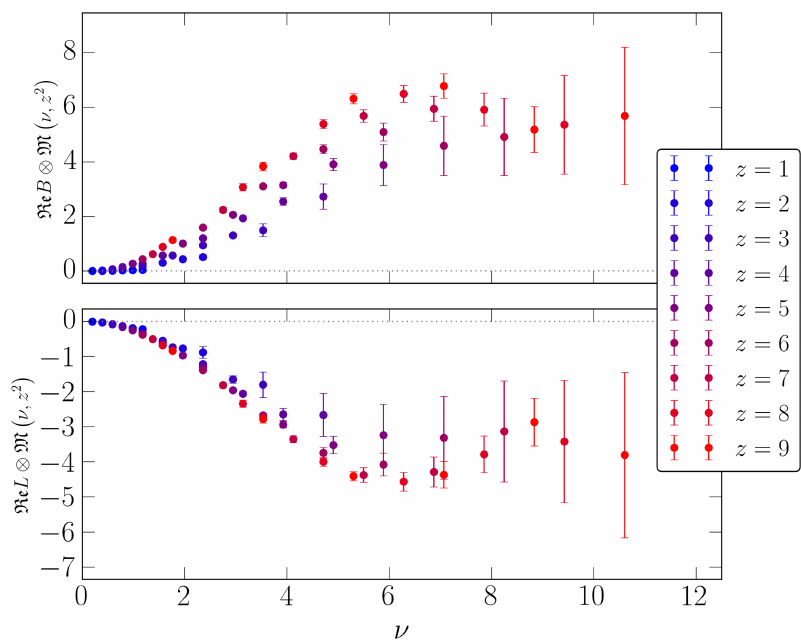
Figure 5. Convolutions needed to evolve (upper) and match (lower) the real component of the reduced pseudo-ITD to a common scale of 2 GeV in MS. The NLO prefactor α these data, but omitted from the labels for clarity. The convolutions were performed up to z/a = 16 , but data for z/a > 9 are generally noisy and not